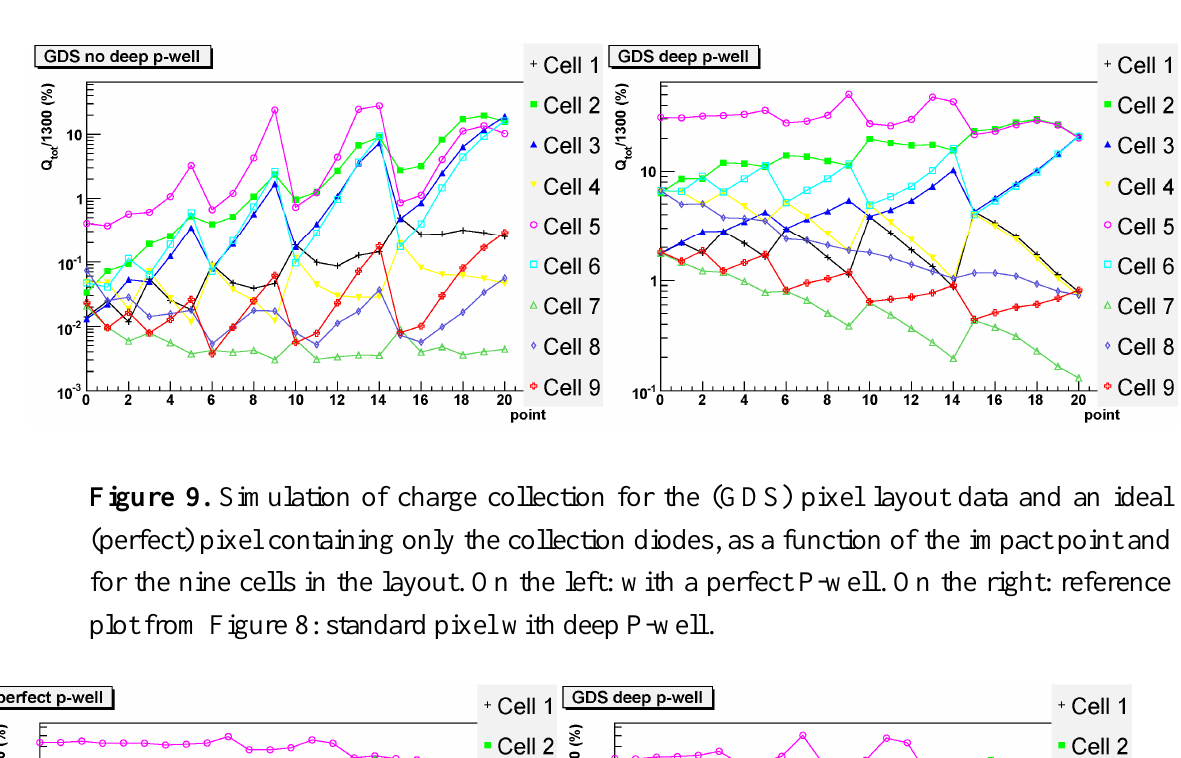
Figure 8. Simulation of charge collection for the (GDS) pixel layout data, as a function of the impact point as labeled in Figure 7 and for the nine pixels (cells) in the layout. On the left: without deep P-well. On the right: with deep P-well.